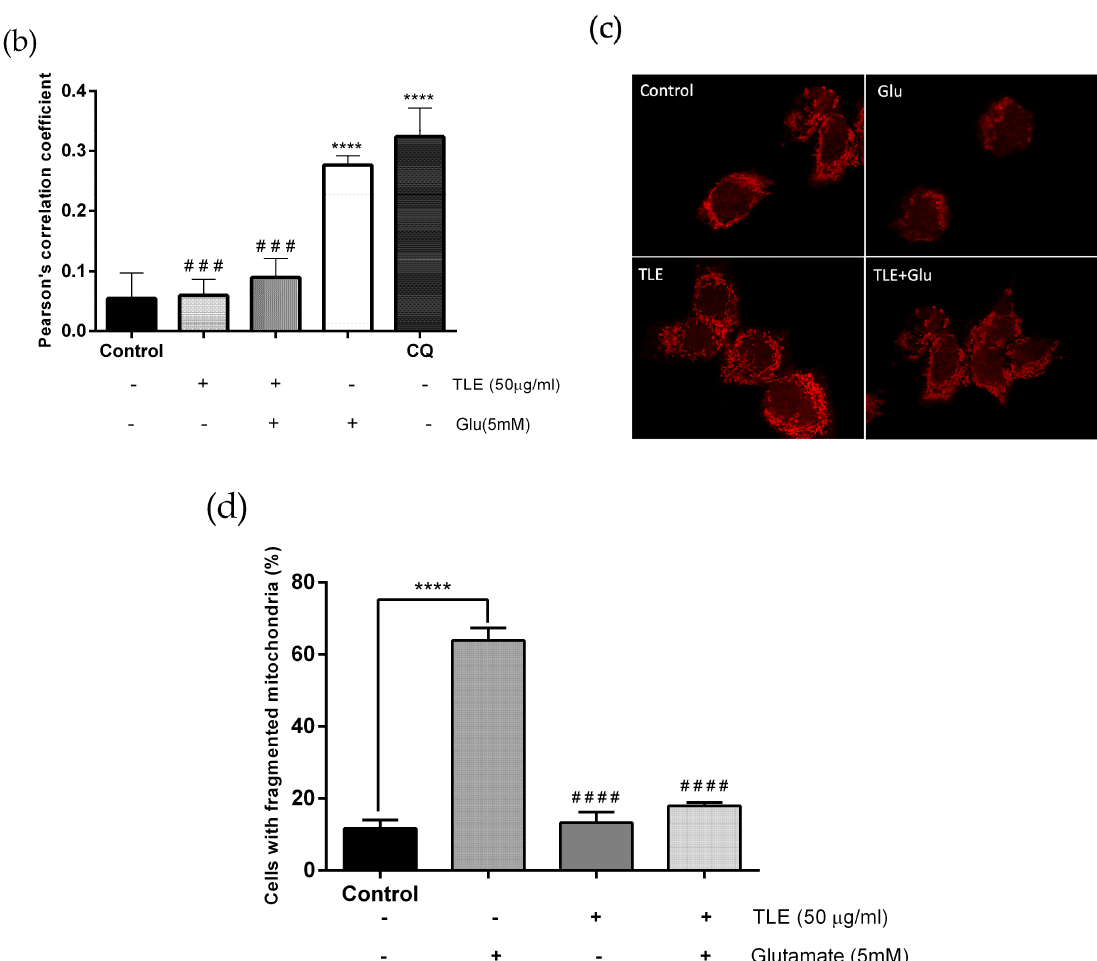
Figure 7. The immunofluorescence staining of LC3B protein and mitochondria. HT-22 cells (passage 10–12) were pretreated with 50 µ g/mL of TLE followed by 5 mM glutamate for 18 h and 50 µ M chloroquine (CQ) alone for 18 h is used as positive control ( a ) HT-22 cells were stained with the mitochondria (Mitotracker: red), LC3B protein (Alexa 488: green) and nucleus (DAPI: blue). They were observed under the confocal laser scanning microscope (scalebar is 10 µ m). ( b ) The bar graph of co-localization was considered with Pearson’s correlation coefficient. ( c ) Micrograph of mitochondrial morphology. The normal morphology of mitochondria (tubular and round forms) was shown in the cell control. Glutamate altered the mitochondrial morphology, causing the mitochondrial fragmentation. ( d ) The numbers of cells with mitochondrial fragmentation were quantified as a percentage, data represent the means ± SEM ( n = 3) and the averages of cells are at least 20 cells. **** p value < 0.001 compared with untreated control ### p value < 0.005, #### p value < 0.001 compared with glutamate-treated group.